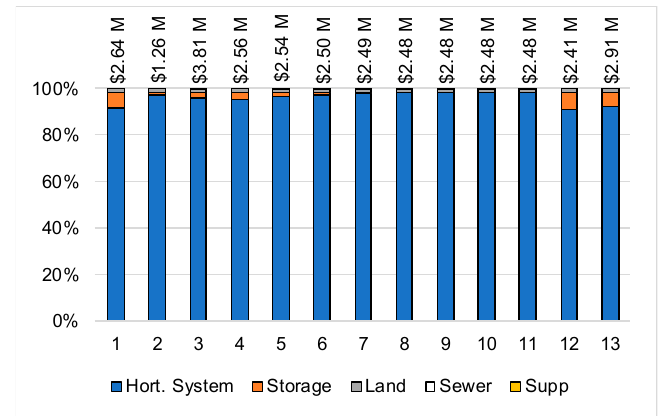
Figure 9. Capital expenditure breakdown for hydroponic systems in greenhouse conditions (HYDRO-GH) in Parafield climate (M = ‘000,000).